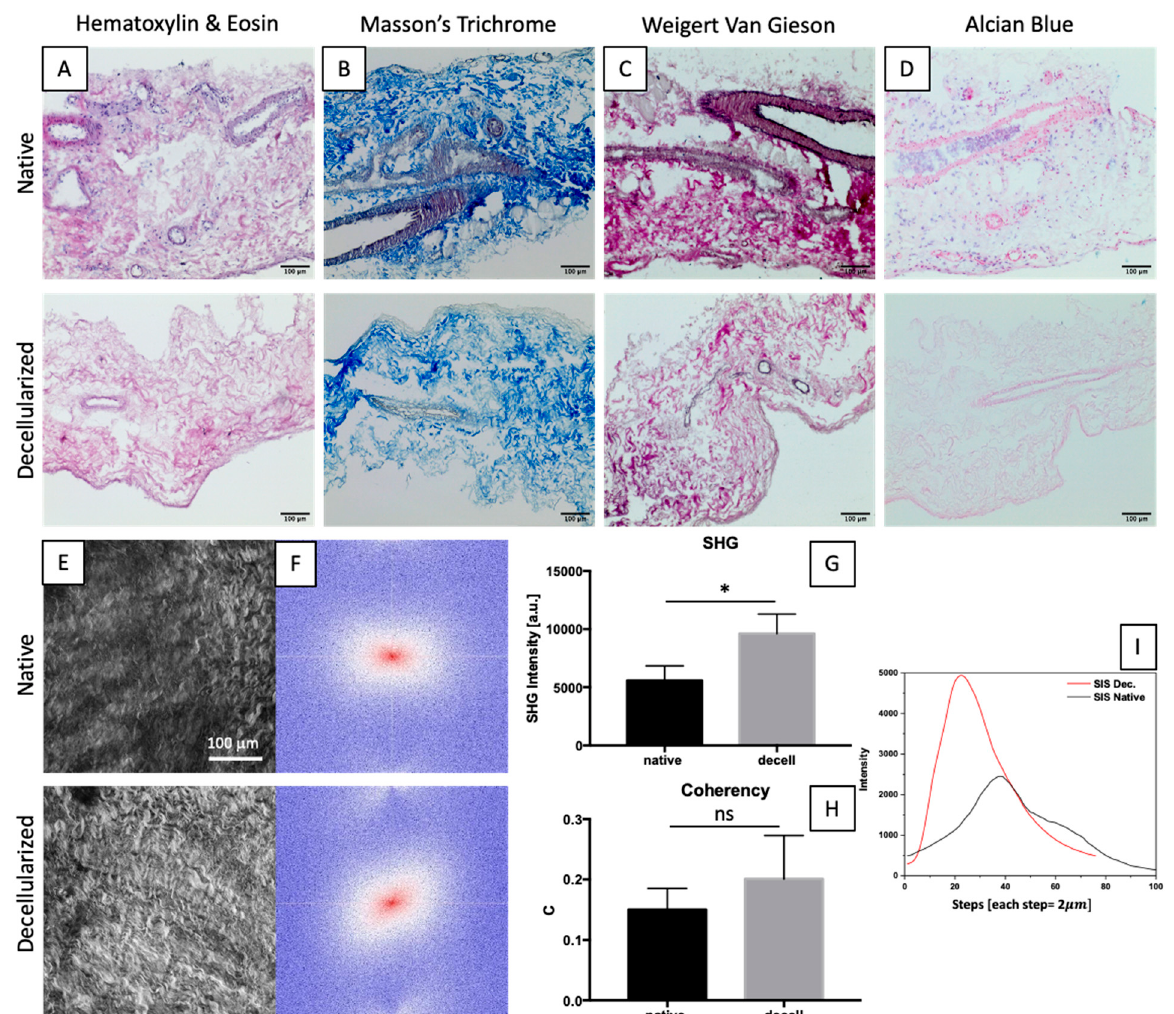
Figure 2. Histological analyses of native and decellularized SIS. H&E shows the effective nuclei removal in decellularized tissue ( A ). Collagen and elastic fibres are revealed by Masson’s Trichrome ( B ) and Weigert–van Gieson ( C ) stainings, respectively. Alcian Blue shows the presence of glyco- proteins ( D ). Z-stack of max intensity of phase contrast of native and decellularized SIS ( E ) and representative FFT ( F ). SHG intensity values from z-stack measurements ( G ). Coherency analysis from z-stack ( H ). Data on graphs show mean ± SD. Data analysed by t -test. * p < 0.05. Representative intensity profile for native and decellularized samples for each step during z-stack acquisition ( I ).